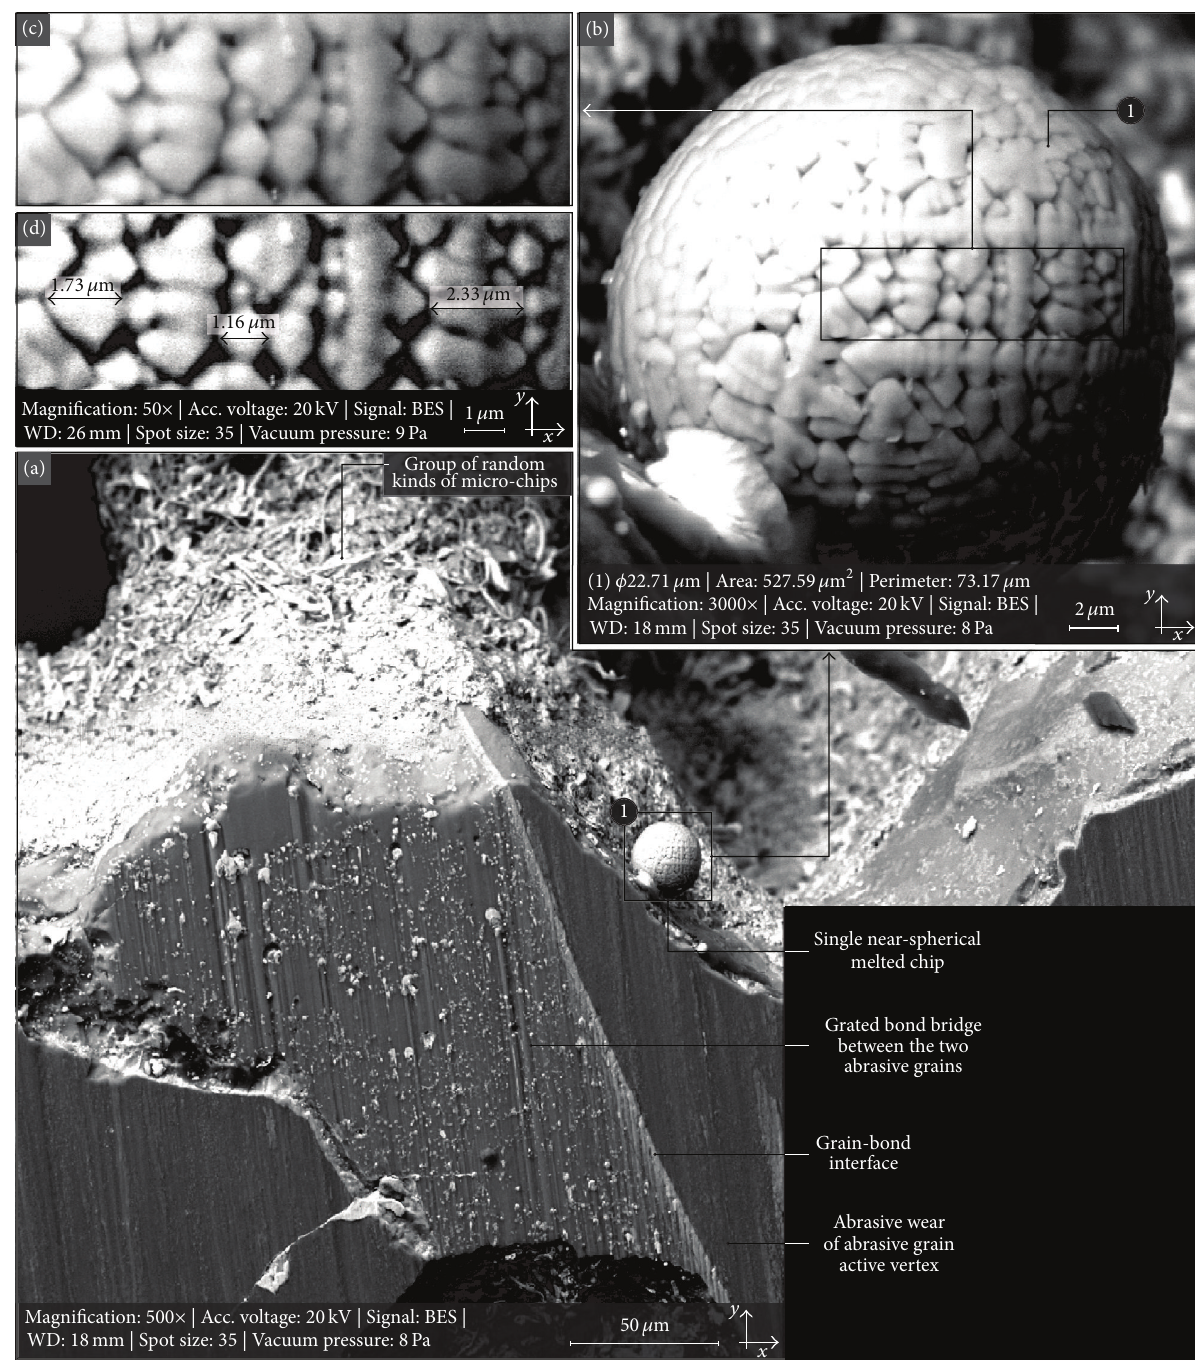
Figure 2: General morphology of near-spherical melted chip formed after internal cylindrical plunge grinding of 100Cr6 steel obtained by use of scanning electron microscope, JSM-550LV, produced by JEOL: (a) SEM micrograph (size: 388.88 × 297.77 𝜇 m, mag. 500 × ) of GWAS 1–35 × 20 × 10-SG/F46K7VTO with centrally positioned single near-spherical melted chip, (b) AOI (size: 25.34 × 25.08 𝜇 m, mag. 3000 × ) extracted from (a) with calculated basic dimensions of chip, (c) AOI (size: 12.13 × 3.87 𝜇 m, mag. 5500 × ) extracted from (b) with visible structure of chip, and (d) image from (c) after use of filtering process (high-pass filter). Note: Acc. voltage, accelerating voltage; BES, backscattered electron (shadow image); WD, working